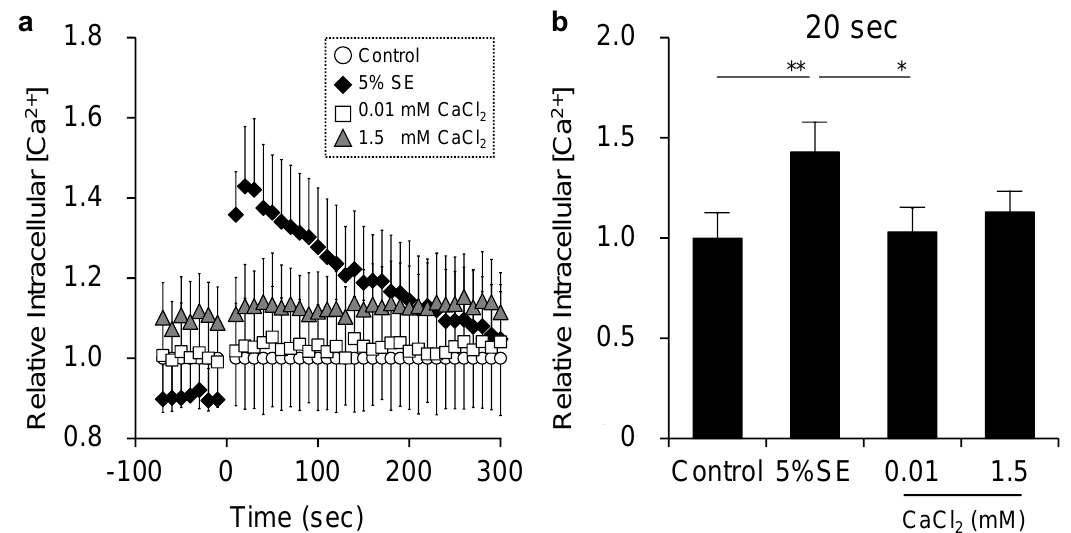
Figure 5. Effects of Shotokuseki extract on intracellular calcium concentration in NHEKs. Intracellular calcium concentration was evaluated as detailed in the Materials and Methods section using Fura-2 AM. (a) intracellular calcium concentration profile intracellular calcium concentration profile (b) intracellular calcium concentration after 20 s. Data represent the mean ± S.D. of four independent experiments. * p < 0.05 and ** p < 0.01. Statistical significance was evaluated using the Tukey’s post hoc multiple comparison test.